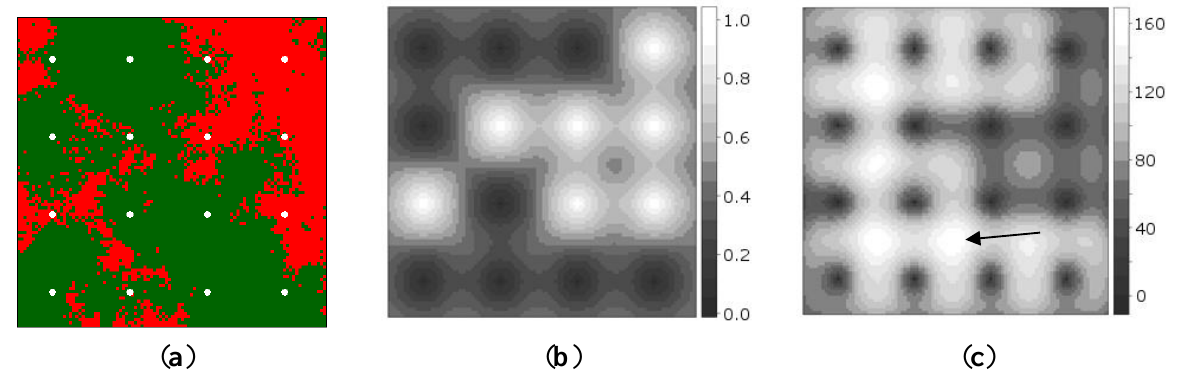
Figure 2. Static field. ( a ) Presence (red), absence (green) and initial sample (white dots). ( b ) Probability of presence; the point at the third row from above and third column from the left was incorrectly measured (random measurement error). ( c ) Global EVOI; the arrow points to the location having highest global EVOI. Probability and EVOI were computed from the initial sample of 16 regularly spaced points (a).